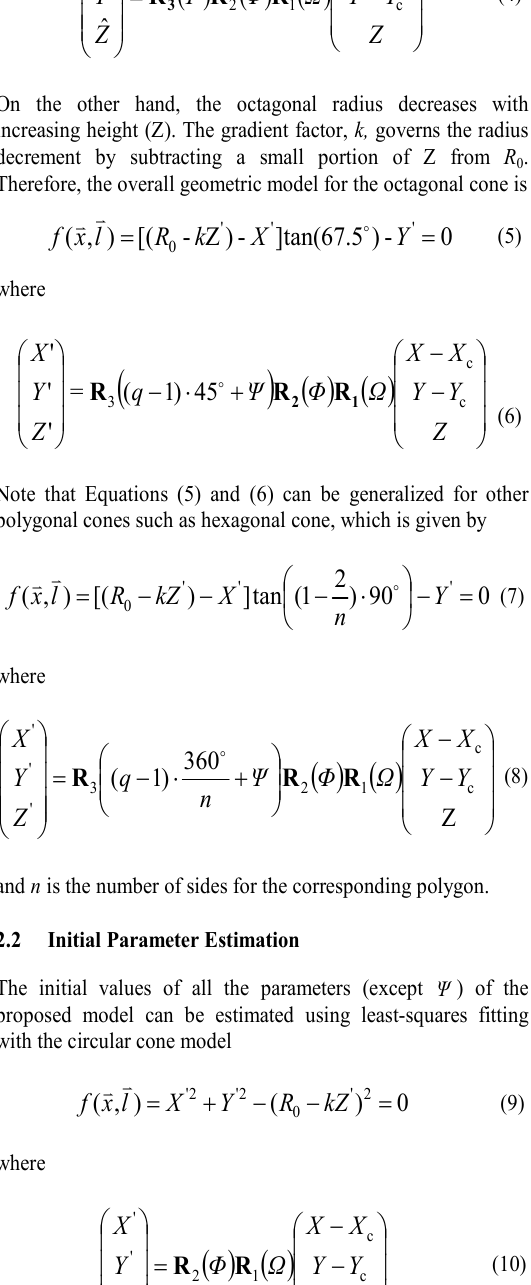
and q can be calculated as